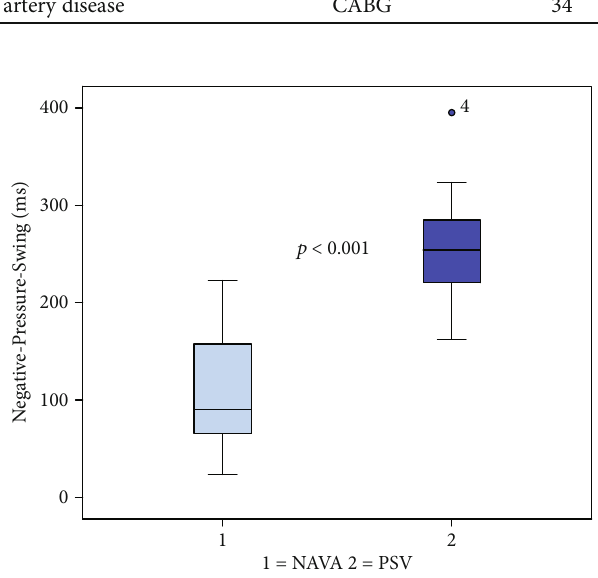
Figure 1: Whiskers-boxplots of negative pressure swing as a surrogate for